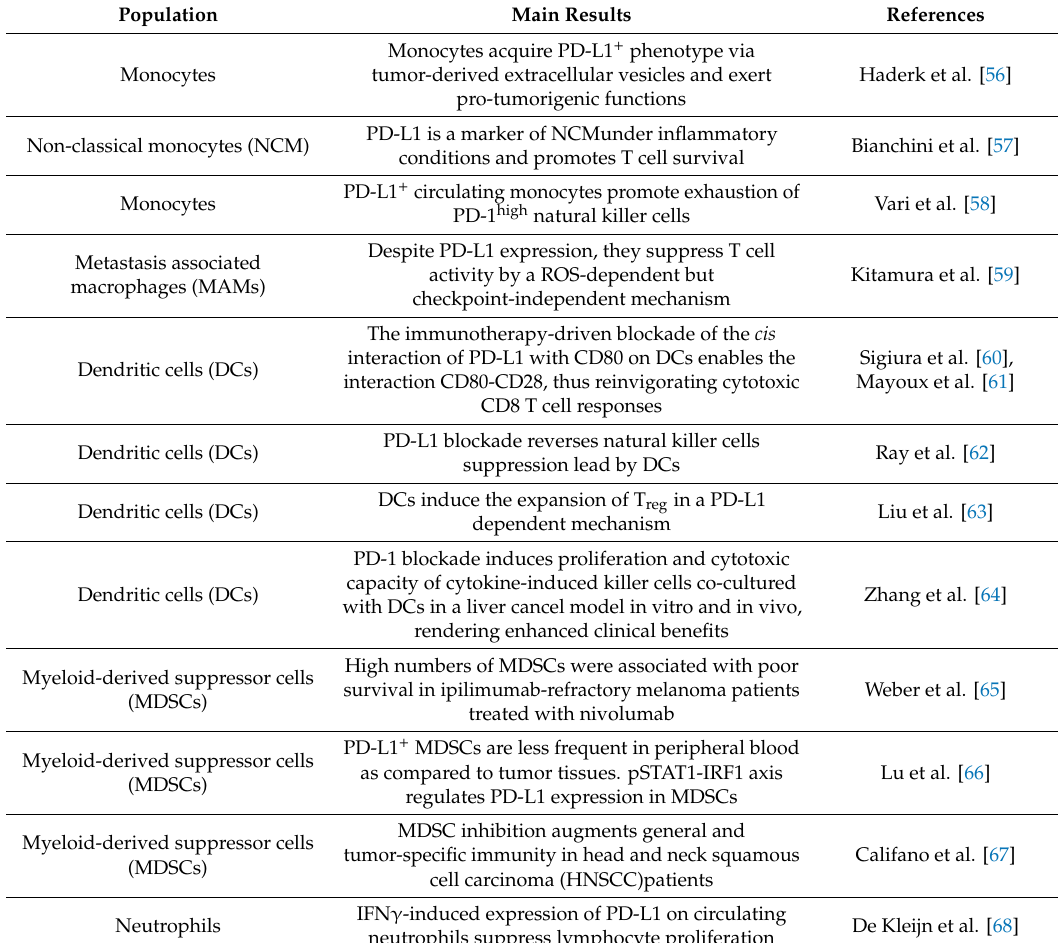
Table 2. Summary of studies on PD-L1 in peripheral myeloid